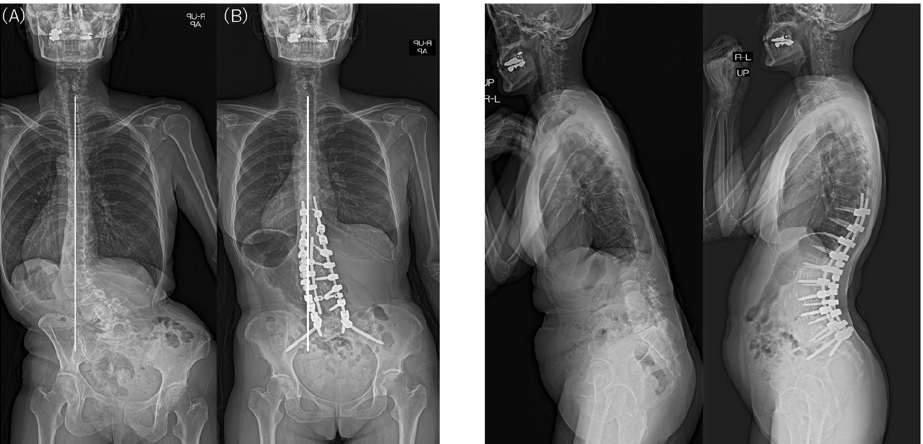
Figure 3. Preoperative and postoperative standing radiographs showing coronal and sagittal correc- tion using anteroposterior staged surgery for ASD in a 55-year-old woman with type 2 CM. CBD changed from –86.7 mm preoperatively ( A ) to –38.8 mm postoperatively ( B ), with the C7 plumb line on the same side as the CBD. Sagittal alignment improved significantly, but CBD remained at ≥ 20 mm postoperatively. CM, coronal malalignment; CBD, coronal balance distance.